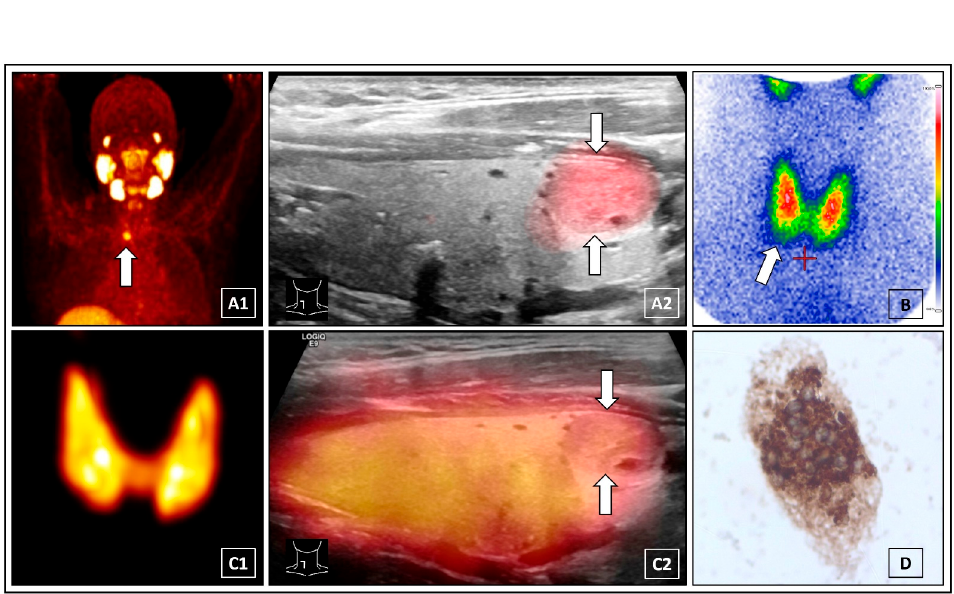
Figure 1. Prostate-specific membrane antigen (PSMA) “theranostics” is gaining increasing importance in the treatment of prostate cancer [1]. A 54-year-old male diagnosed with prostate cancer presented to our clinic for 68 Gallium-PSMA-11 PET/CT. The PET-scan incidentally revealed a solitary PSMA-positive lesion of the thyroid gland ( A1 , white arrow). There was no history of thyroid pathologies and laboratory thyroidal values were normal. Subsequently, 68 Gallium-PSMA-11 PET/ultrasound (US) fusion imaging was performed and unambiguously depicted a solitary PSMA- positive thyroid nodule (15 × 13 × 8mm) in the lower right lobe ( A2 , white arrows), classified as Kwak-TIRADS 4B [2]. PSMA-positive thyroid uptake can be related to several diagnoses, including thyroid cancer, metastases of prostate cancer or renal cell carcinoma, benign thyroid nodules, and de Quervain’s thyroiditis [3–5]. 99m Tc-scintigraphy did not clearly characterize the nodule ( B , white arrow) and therefore cervical 124 Iodine PET/CT was performed. The 124 Iodine maximum intensitiy projection (MIP) PET imagiges did not reveal any hyper- or hypofunctional thyroidal lesions ( C1 ).